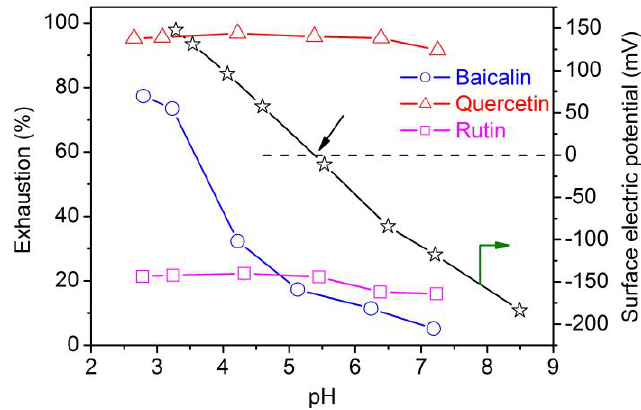
Figure 2. pH Dependence of flavonoids adsorption and surface electric potential of polyamide fiber.